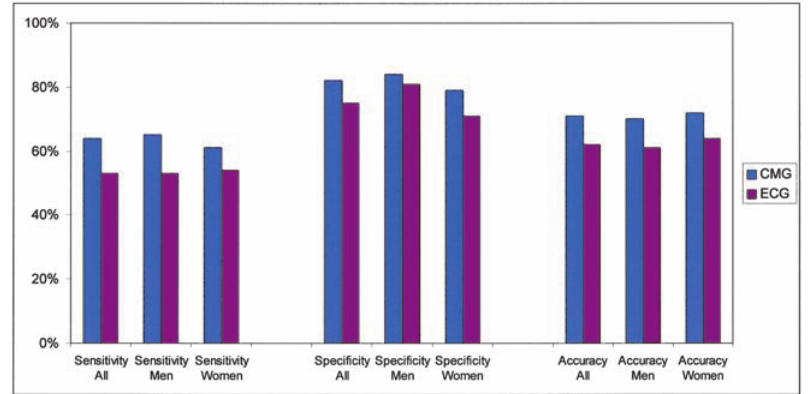
Diagnostic sensitiv- ity, specificity, and accuracy of CGM and